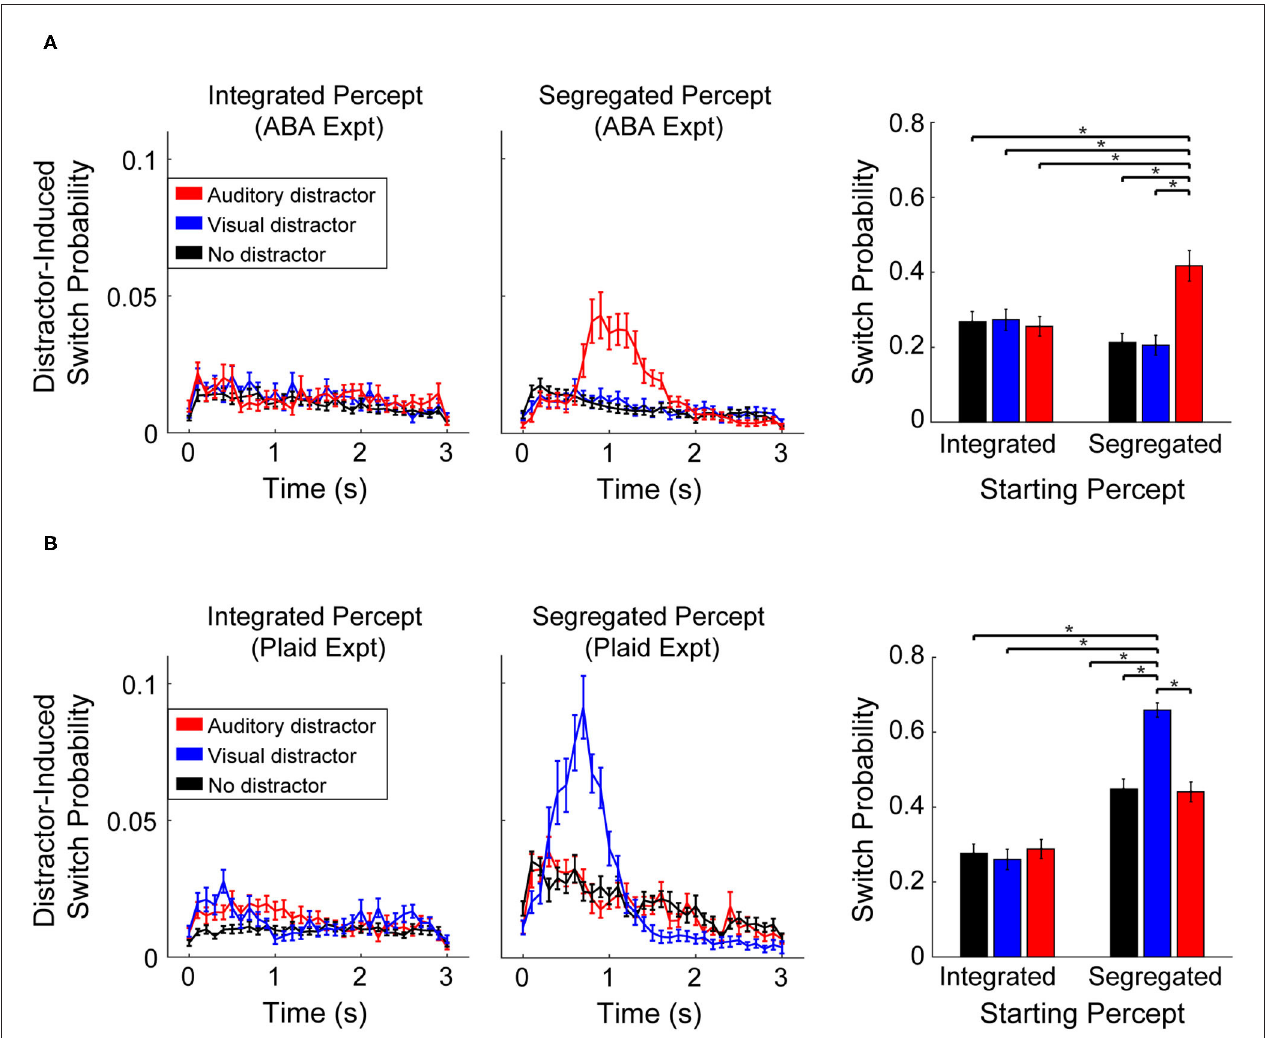
FIGURE 3 | Probability of a switch following presentation of an auditory distractor (red), visual distractor (blue), or no-distractor (black). Line plots represent the probability time-course of a switch in perception (in 100ms increments) following distractor presentation during an integrated (left column) or segregated percept, at distractor onset. Bar plots (right column) represent the cumulative probability of a perceptual switch following distractor (or no-distractor) presentation, measured over the time window from 300 to 2,000ms (an extended time interval is shown here for illustrative purposes). Error bars correspond to SEM across participants. (A) Effect of distractor during the ABA-experiment. (B) Effect of distractors during the